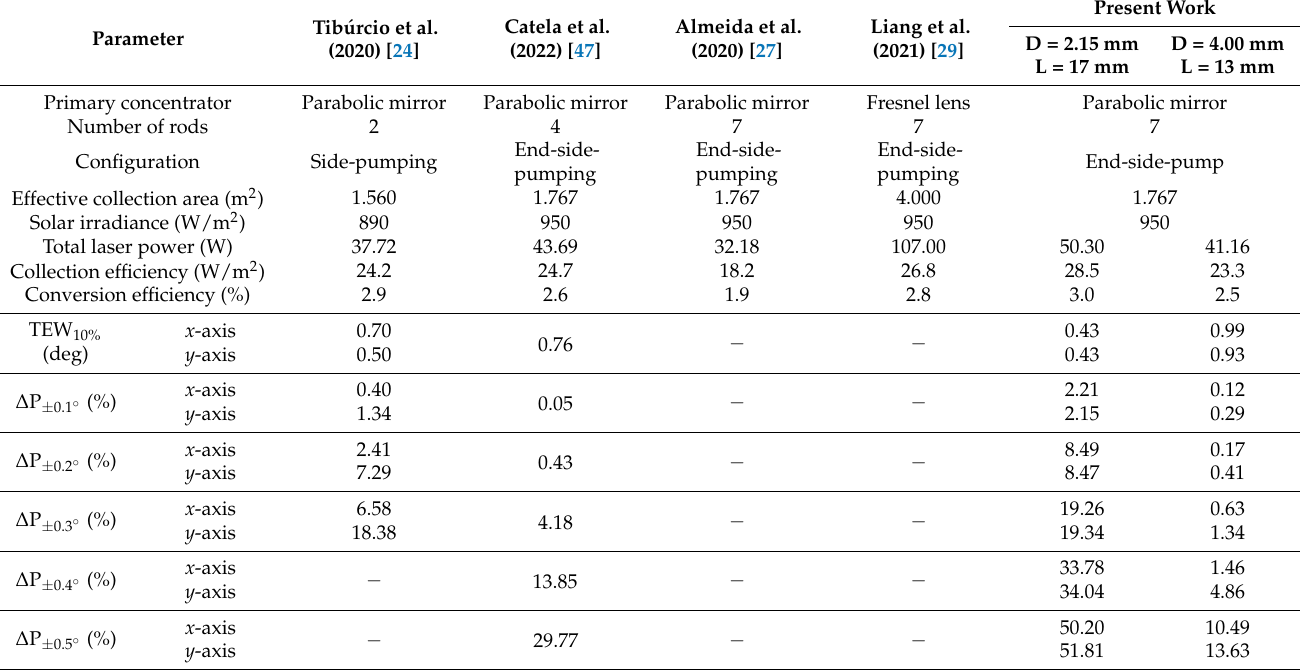
Table 2. Comparison between the results in multimode regime of the present work and the ones